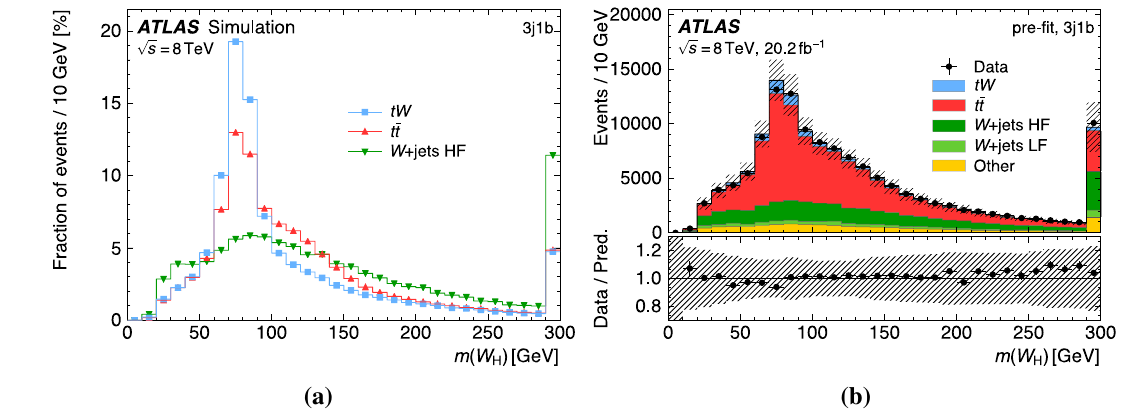
Fig. 2 a Shape of the reconstructed m ( W H ) distribution for signal and most important backgrounds in the signal (3j1b) region. The distribu- tion for each process normalised to unity is shown. b Pre-fit m ( W H ) distribution in the 3j1b region. Small backgrounds are subsumed under ‘Other’. The simulated distributions are normalised to their theoretical